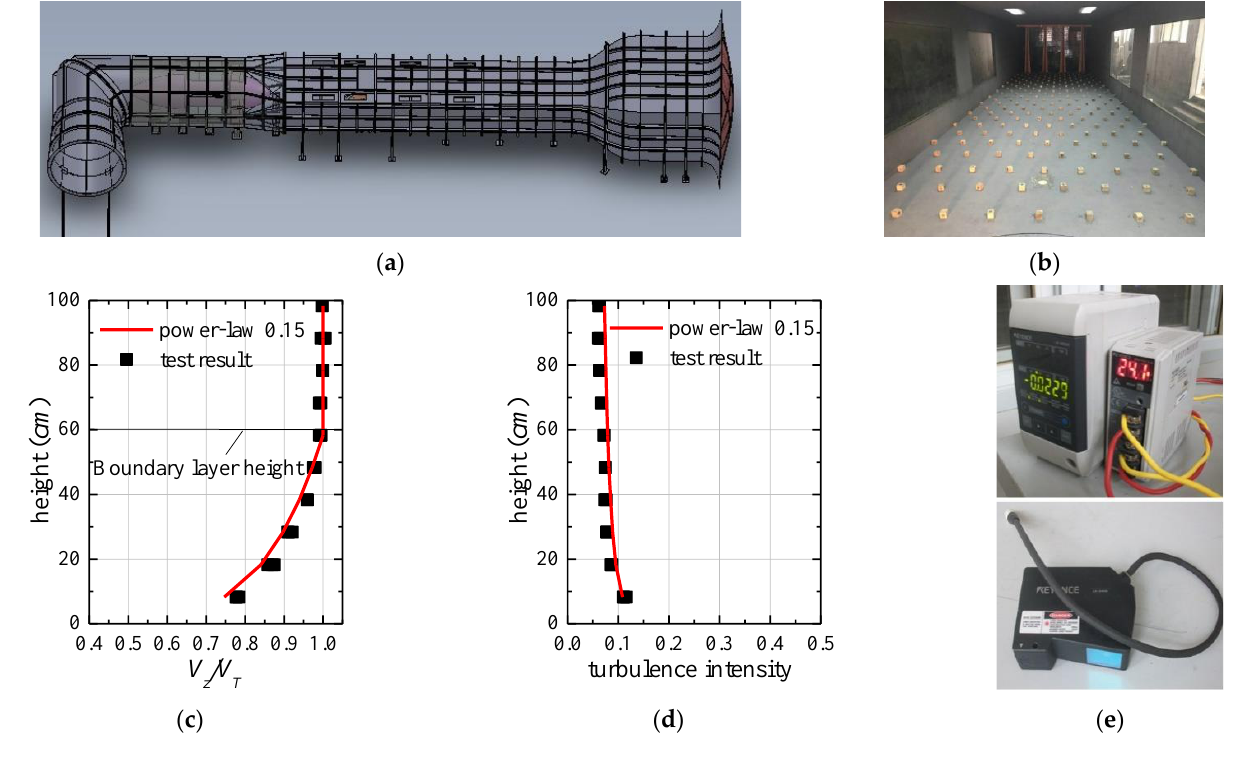
Figure 2. Wind tunnel and measuring instrument of this study: ( a ) aerodynamic contour of the wind tunnel; ( b ) simulation of the wind field; ( c ) mean wind velocity; ( d ) turbulence intensity; ( e ) laser displacement meter.